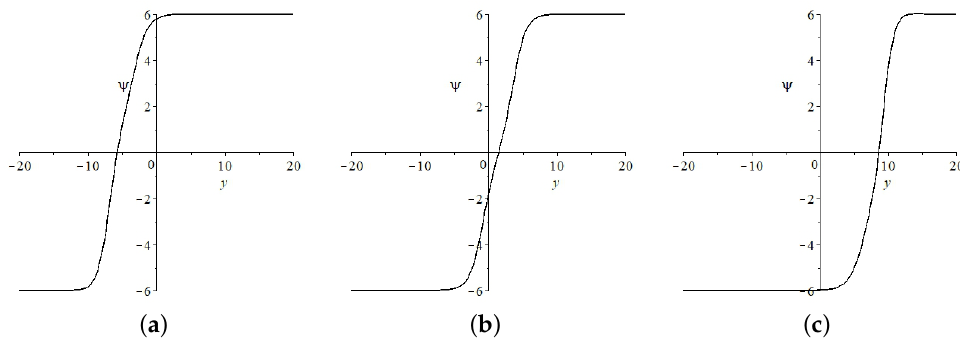
Figure 5. (Color online) Quasi-kink soliton with r 2 = r 3 = r 4 = r 6 = r 7 = r 8 = 1, β 1 = 2, γ 1 = 0, κ 1 = 0, a 1 = 1, b 1 = 0.1, c 1 = 1, d 1 = 0, e 1 = 1.2, f 1 = − 2.5. ( a – c ) show quasi-kink soliton moves along the y axis when t = − 1, t = 0 and t = 1,